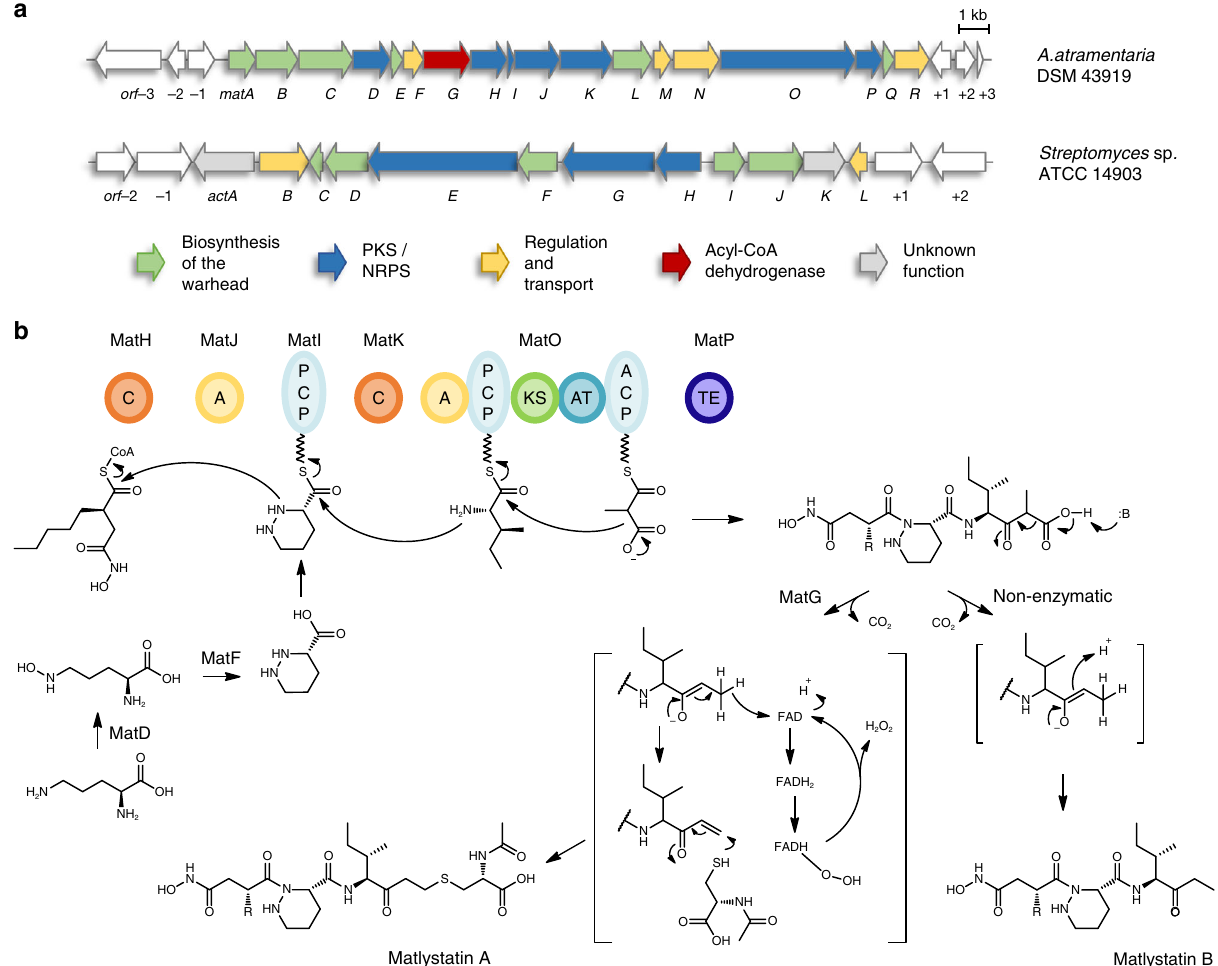
Fig. 2 Biosynthesis of hydroxamate metalloproteinase inhibitors. a Organization of the mat and the act biosynthetic gene cluster from A . atramentaria DSM 43919 and Streptomyces sp. ATCC 14903 (NCIMB 8845), respectively. b Biosynthetic model for the assembly and modi fi cation of the matlystatins.